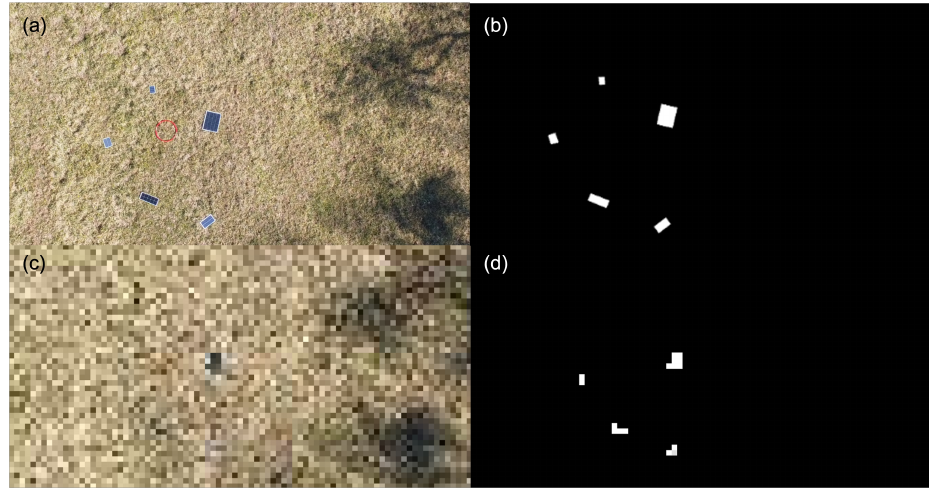
Figure A1. Satellite resolution view of SHS compared with a UAV example. ( a ) Original UAV imagery with GSD of 2 cm. ( b ) Human labeled ground truth of the SHS. ( c ) Simulated Satellite imagery with GSD = 30 cm. ( d ) Simulated ground truth of SHS at the resolution of satellite